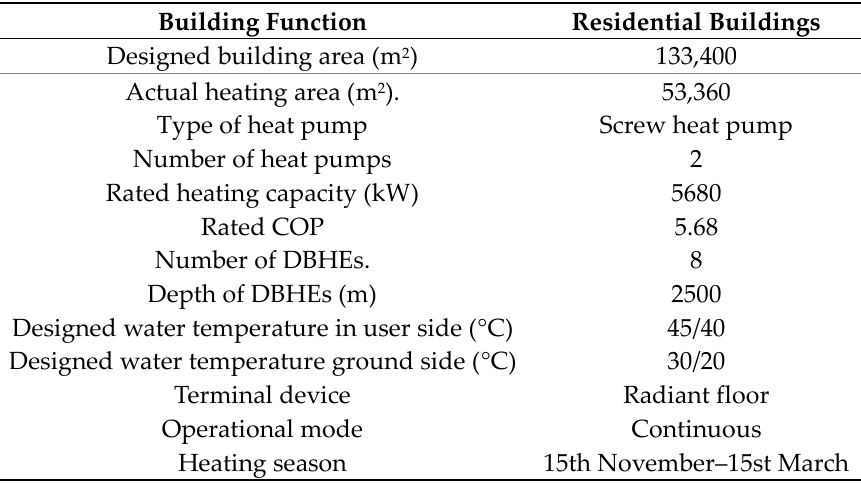
Table 1. Basic information of field tested